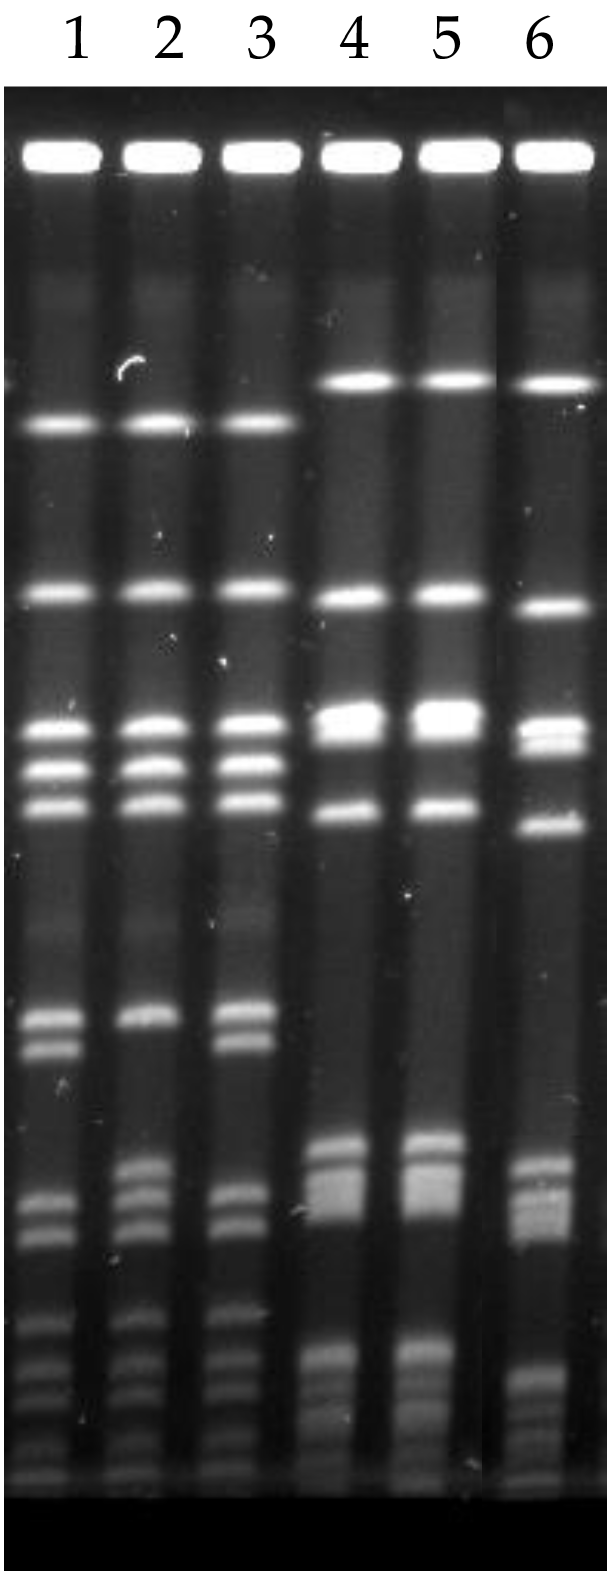
Figure 1. Pulsed-field gel electrophoresis (PFGE). Lanes 1–3 are Patient A’s (pelvic trauma patient) methicillin-resistant Staphylococcus aureus (MRSA) isolates from the first set of blood cultures (day 12), groin swab, and third set of blood cultures (day 13), respectively. Lanes 4–6 are Patient B’s (colonoscopy patient) MRSA isolates from nasal swab, blood culture, and rectal swab,